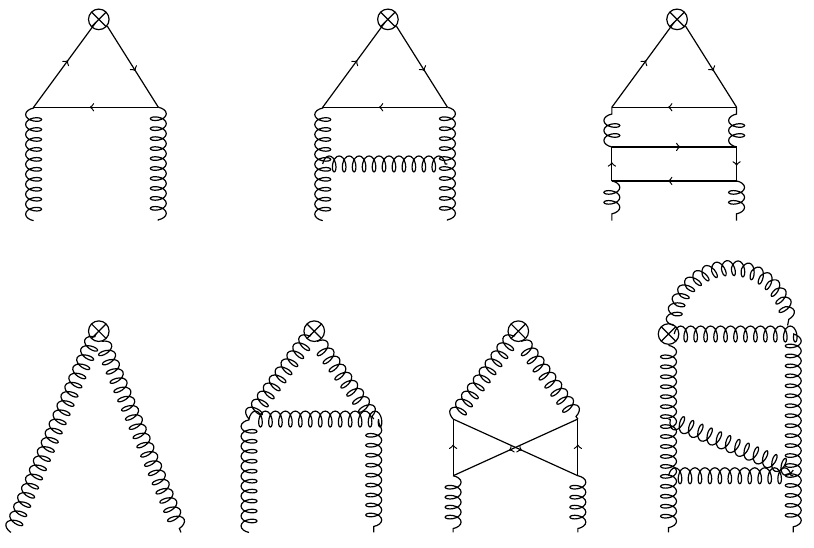
Figure 3 . Sample Feynman diagrams up to 3-loop order contributing to the matrix elements M lhs (upper row) and M (lower rhs